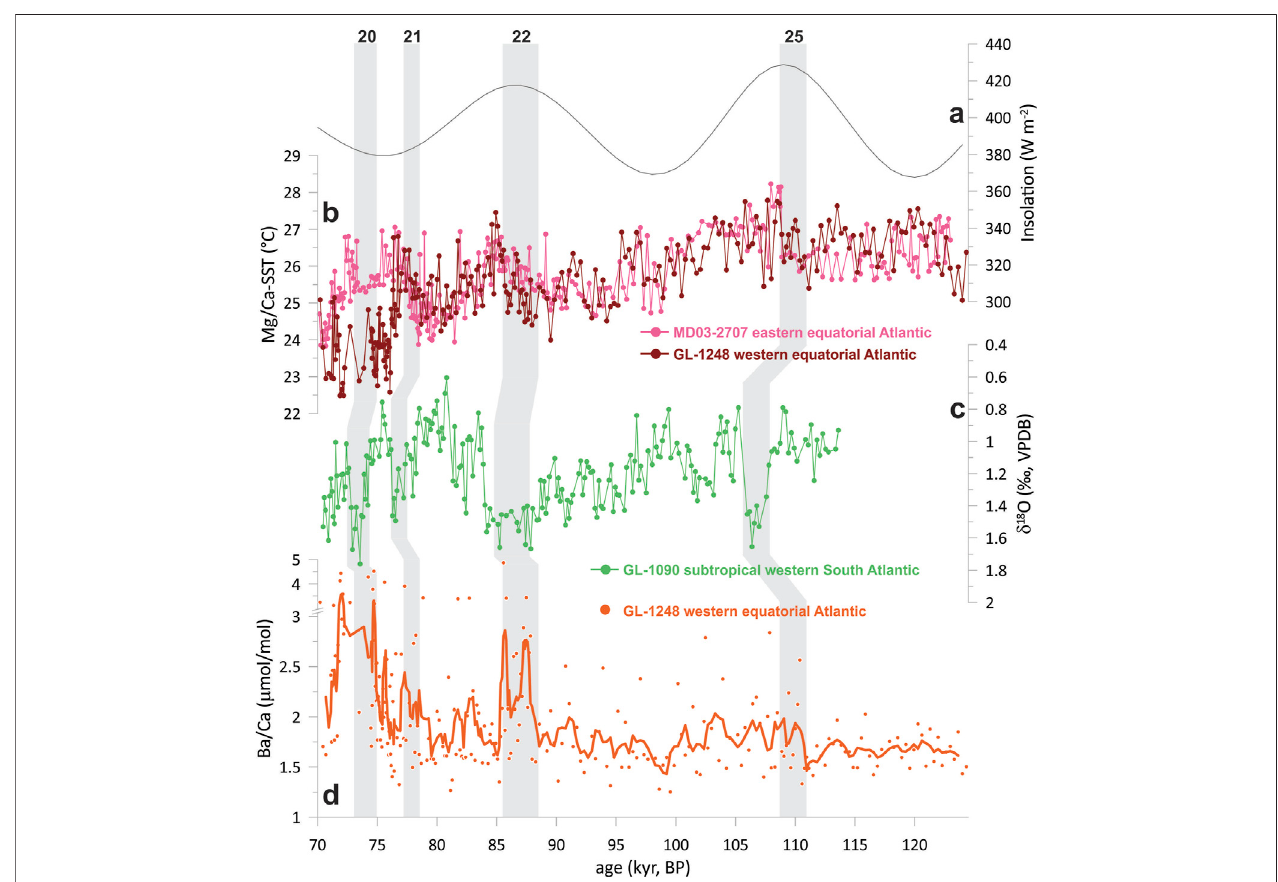
FIGURE 4 | Climatic forcings related to the tropical climate response to Dansgaard-Oeschger stadials. (A) Austral autumn insolation at 10 ° S (grey line, Berger and Loutre, 1991). (B) Sea surface temperature (SST) derived from Mg/Ca of Globigerinoides ruber (white) from core GL-1248 (red line) and from Mg/Ca of Globigerinoides ruber (pink)fromcoreMD03-2707(pinkline). (C) δ 18 Oof Globorotaliain fl ata fromcoreGL-1090(lightgreenline,Santosetal.,2020). (D) Ba/Caratiosof Globigerinoides ruber (white) from core GL-1248 (orange line). Ba/Ca results are shown as running-average of the data points. Dansgaard-Oeschger stadials are marked by the grey